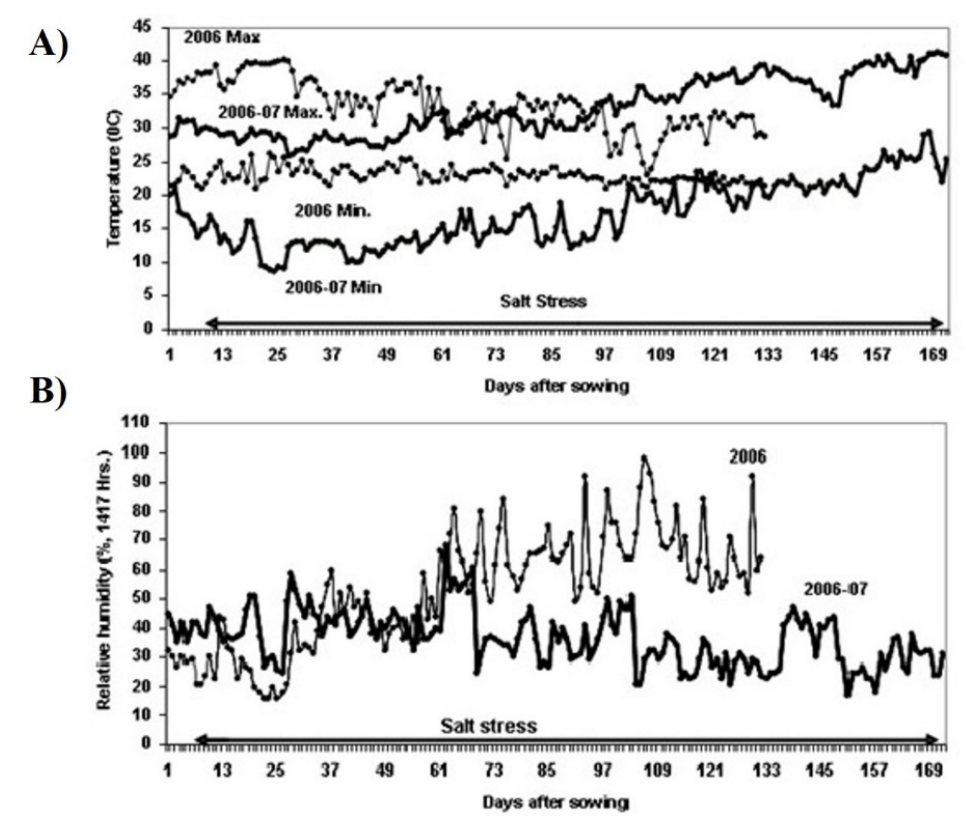
Fig. 1. The temperature and humidity diagram. (A) Minimum and maximum temperature and (B) relative humidity during 2006 (thin line) and 2006-2007 (thick line) at ICRISAT,